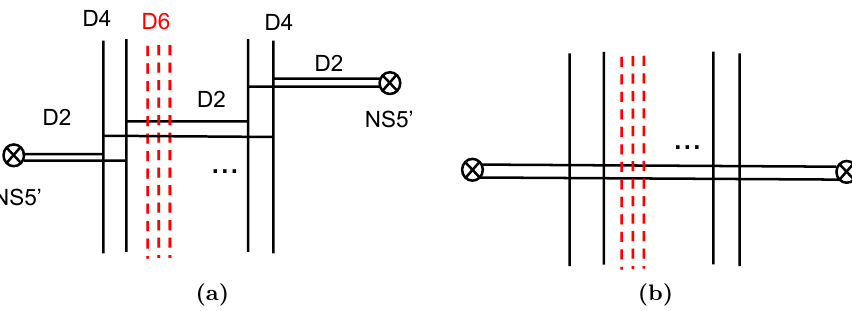
Figure 11. (b) two D2-brane suspended between D4-branes are introduced to describe ’t Hooft- Polyakov monopole which screen the magnetic charge. (c) After Hanany-Witten effects, we obtain a brane configuration for the SQM with v = 0